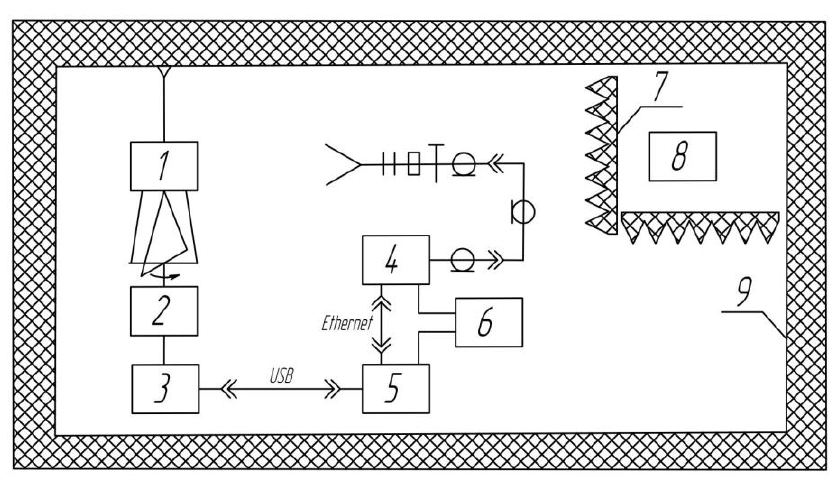
Fig. 2. The schematics of backscattering characteristics measuring bench for small and ultrasmall objects RCS in K a -band.